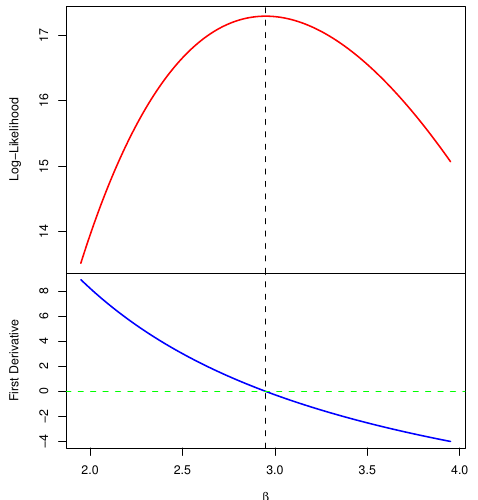
Figure 1. The log-likelihood function and the associated first derivative of β